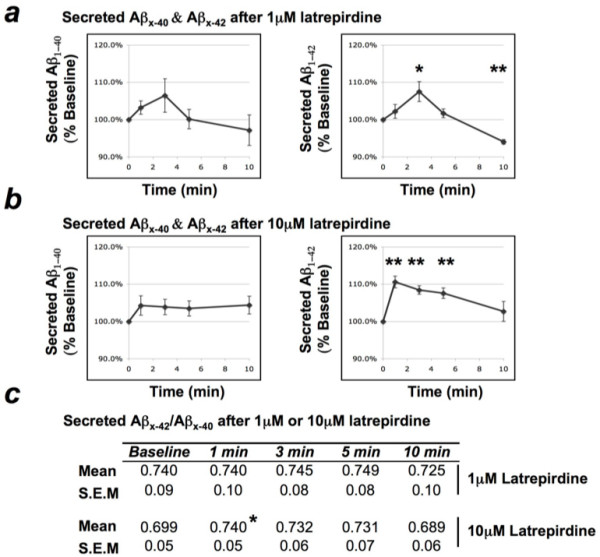
Secreted Aβx-40 and Aβx-42 levels in the releasates of synaptoneurosomes following incubation with latrepirdine. Post-natal day 10-14 TgCRND8 cortical synaptoneurosomes were incubated 0 (baseline), 1, 3, 5, or 10 minutes in the presence of 1 μM (n = 5) or 10 μM (n = 6) latrepirdine. (a) 1 μM latrepirdine stimulates an increase in secretion of Aβx-42, but not Aβx-40, from isolated synaptoneurosomes following 3 minutes (SD = 0.06, t(4) = 2.81, p = 0.048) of incubation with the drug, and a decrease (~6%) is observed at 10 minutes (SD = 0.01, t(5) = 9.61, p = 0.0007), likely representing a depletion of available Aβx-42 (mean % baseline +/- S.E.M). (b) 10 μM latrepirdine stimulates an increase in secretion of Aβx-42, but not Aβx-40, following 1 (SD = 0.038, t(5) = 6.73, p = 0.001), 3 (SD = 0.028, t(5) = 7.35, p = 0.0007), and 5 (SD = 0.056, t(5) = 5.29, p = 0.0029) minutes of incubation with the drug (mean % baseline +/- S.E.M). (c) An immediate ~4.1% increase (SD = 0.13, t(5) = 3.205, p = 0.024) in Aβx-42/Aβx-40 ratio was observed following 1 minute of incubation with 10 μM latrepirdine (mean Aβx-42/Aβx-40). (Note: TgCRND8 mice generate ~50%/50% Aβx-42/Aβx-40 under normal conditions and the increase in Aβx-42/Aβx-40 ratio may be due to the large stimulation of Aβ secretion at this time point). *Value represents a significant mean difference between baseline and time-point by paired t-test, two-tailed α = 0.05, *p < 0.05, **p < 0.01.